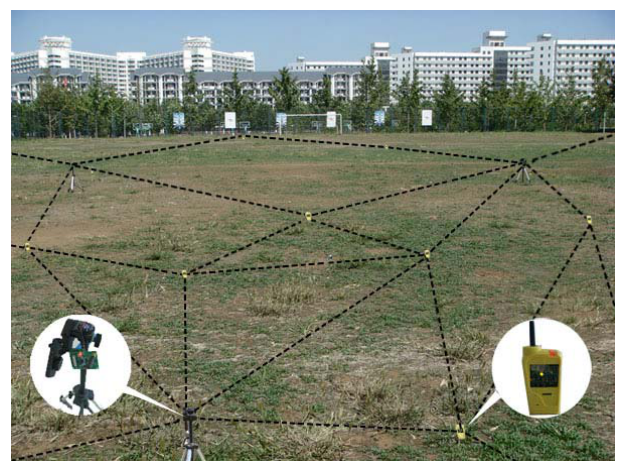
Figure 9. Outdoor